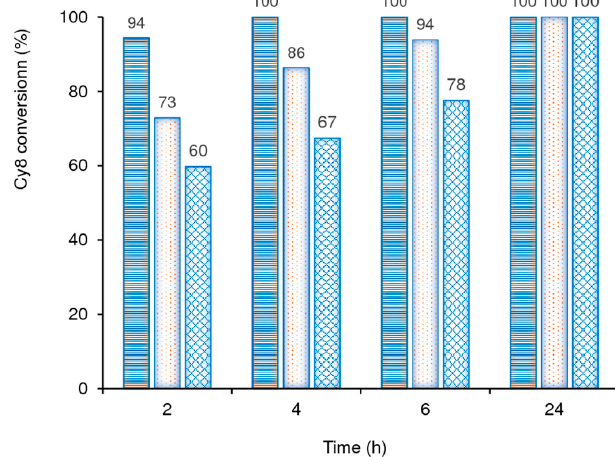
Figure 11. Influence of the post-synthesis IWI versus SSI methods, and the type of support (TUD-1 versus hierBEA) on the Cy8/TBHP reaction at 70 °C: Mo-TUD(IWI-acac) (horizontally-striped bars), Mo-TUD(SSI-acac) (dotted bars) or Mo-hierBEA (diamonds). Epoxide selectivity was always 100%.